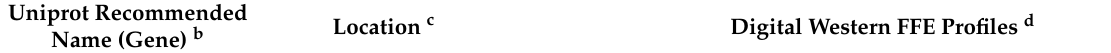
Figure 4. Percentage of the number of distinct proteins for each compartment by (inner pie chart) high-confidence markers (HCM) assignment and (outer pie chart) SUBcellular Arabidopsis consen- sus (SUBAcon) predictions.